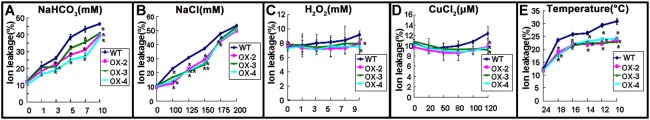
Electrolyte leakage of wild-type (WT) and ChACBP1-overexpressing (OX-2, OX-3, and OX-4) plants after 24 h of treatment with NaHCO3 (0, 1, 3, 5, 7, and 10 mM) (A), NaCl (0, 100, 125, 150, 175, and 200 mM) (B), H2O2 (0, 1, 3, 5, 7, and 9 mM) (C), CuCl2 (0, 20, 50, 80, 100, and 120 μM) (D), or low temperature (24°C, 18°C, 16°C, 14°C, 12°C, and 10°C) (E). Values are means ± SD (n = 3) from three independent experiments. Asterisks indicate significant differences from WT (∗∗P < 0.01, ∗0.01 < P < 0.05).